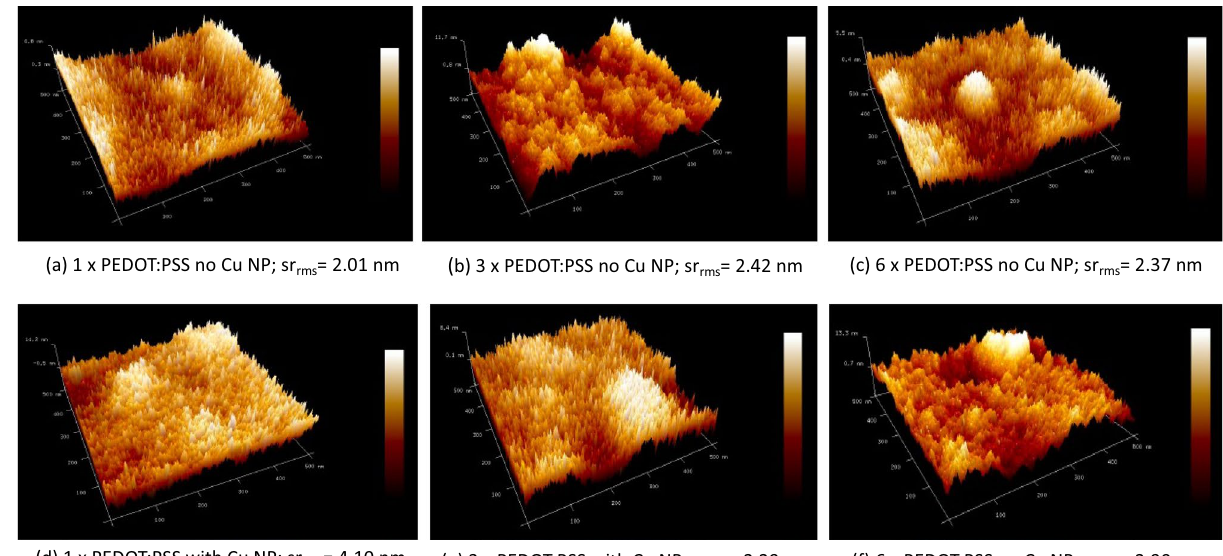
(a) 1 x PEDOT:PSS no Cu NP; sr rms = 2.01 nm ( b) 3 x PEDOT:PSS no Cu NP; sr rms = 2.42 nm (c) 6 x PEDOT:PSS no Cu NP; sr rms = 2.37 nm